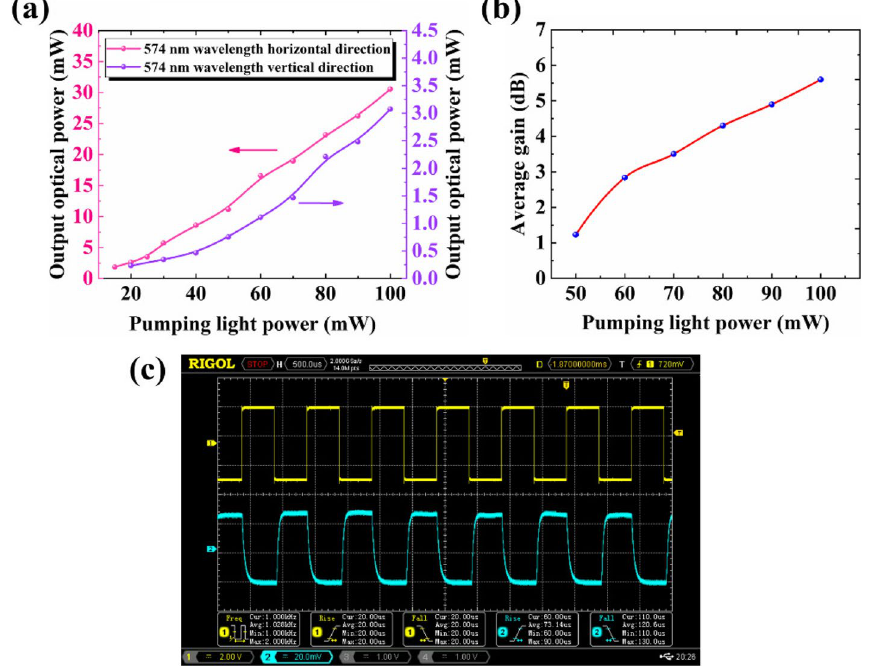
Fig. 12 a Optical power output for dual-microdisk waveguide; b the average gain of white bright source versus CW pumping light power; c the frequency response of white bright source under modulating pulsed optically